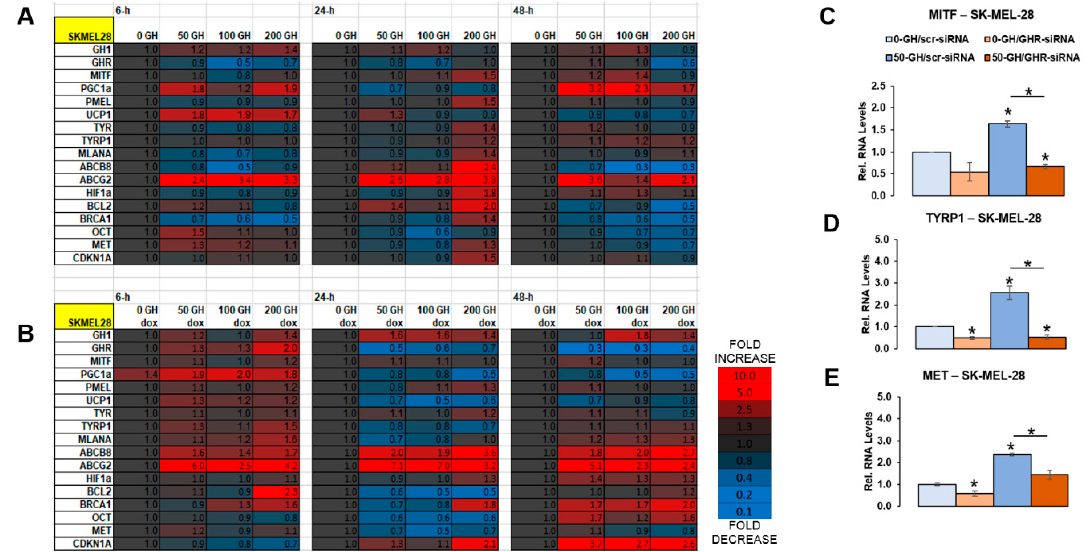
Figure 2. GH treatment directly upregulates MITF and MITF target RNA expression in human melanoma cells: ( A – B ) Human melanotic melanoma cells SK-MEL-28 were treated with increasing doses (0, 50, 100, 200 ng / mL) of recombinant human growth hormone (GH) and heatmap showing changes in RNA expressions at 6, 24, and 48 h timepoints were analyzed for GH, GHR, MITF, and a number of MITF targets, as well as the ABC-transporters ABCB5 and ABCG2 ( A ); An identical experiment was performed in the presence of 200 nM doxorubicin ( B ). Numbers inside boxes indicate fold-change in gene expression compared to GH untreated control. Similar set of experiments for amelanotic melanoma cells SK-MEL-28 is shown in supplementary Figure S2. ( C – E ) SK-MEL-28 cells were further transfected either with scramble (scr) of GHR-targeted (GHR) siRNA for gene knockdown in presence or absence of 50 ng / mL GH treatment and MITF ( C ), TYRP1 ( D ), and MET ( E ) RNA expressions were analyzed. RNA expressions were quantified by RT-qPCR and normalized against expression of TUBB5 and ACTB as reference genes (*, p < 0.05, Wilcoxon sign rank test, n = 3).